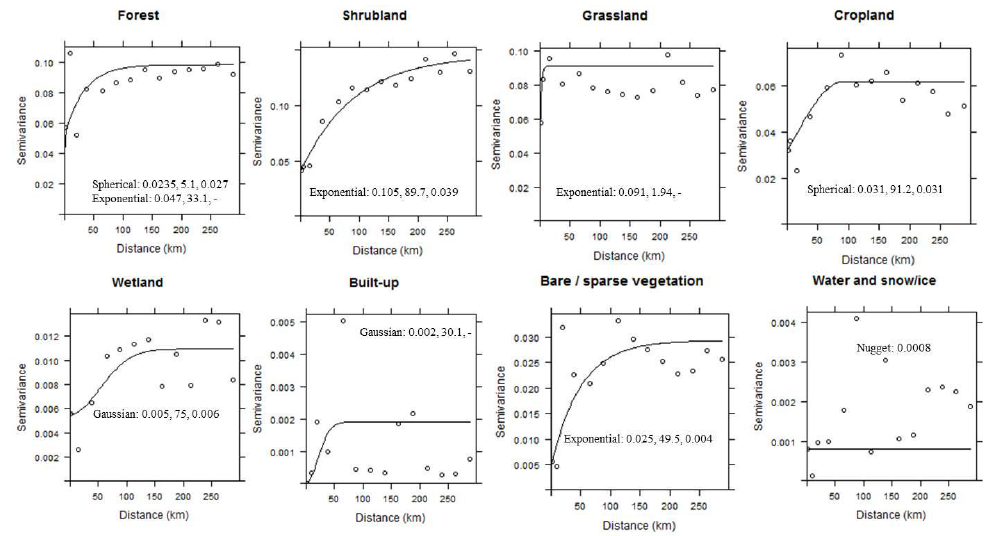
Figure 5. Semivariograms and fitted models for residual kriging.